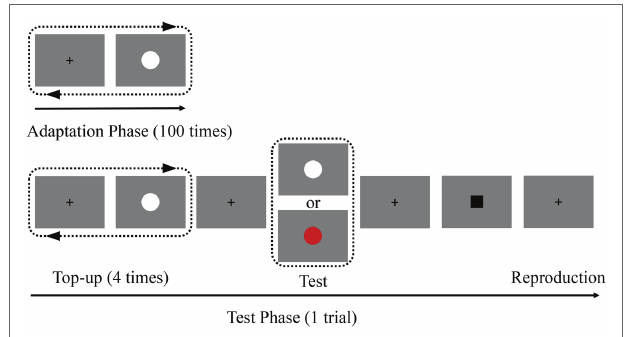
FIGURE 1 | Schematic representation of the experiment. In the adaptation phase, participants viewed 100 repetitions of the adaptation stimulus (white disk; 200 or 800 ms) in the center of the screen. In the subsequent test phase, participants were asked to press the “ENTER” key to reproduce the duration of the test stimulus when the black square appeared. The colors of the test stimuli were presented randomly.